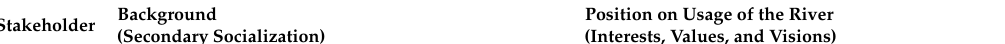
Table A1. Overview of individual stakeholders per institution concerning their backgrounds and positions on the usage of the